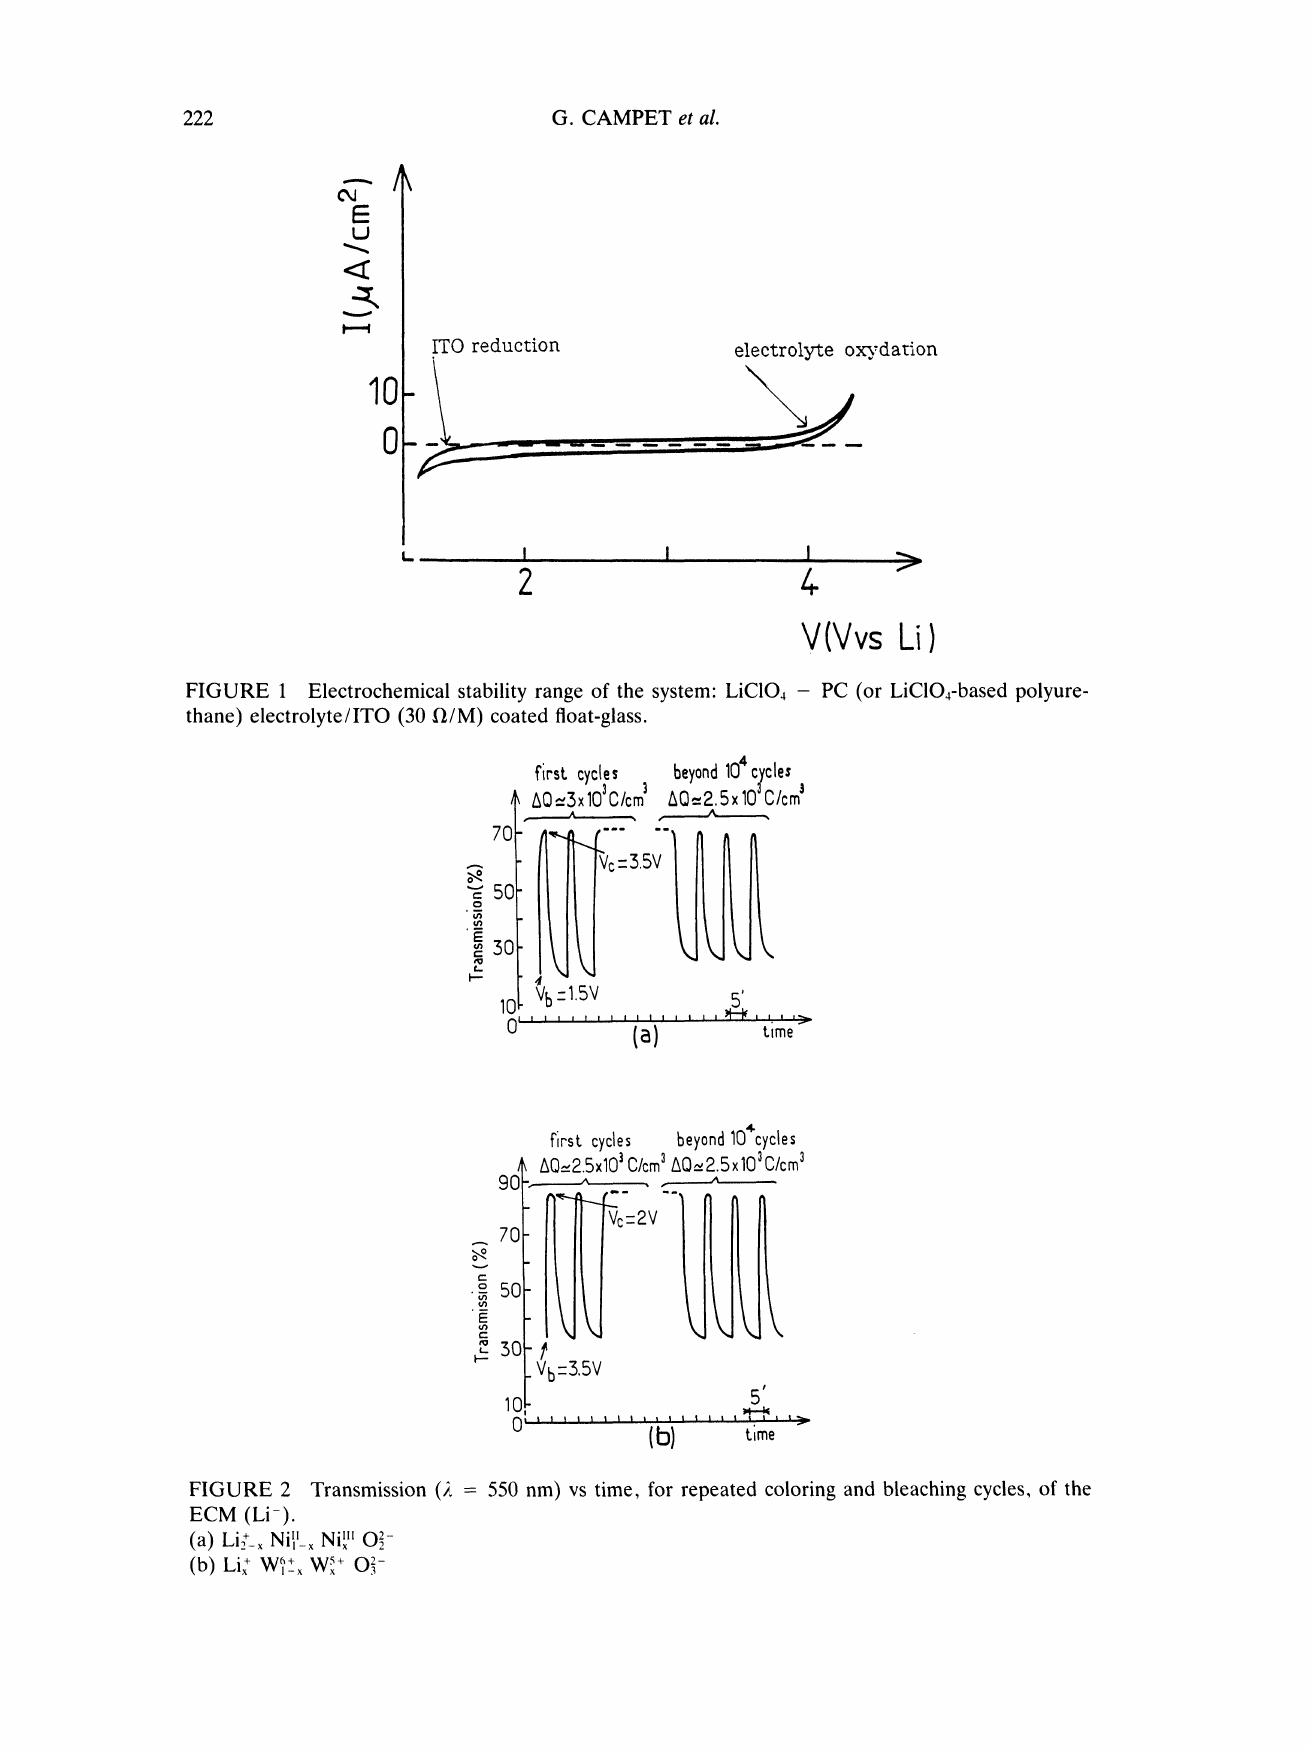
FIGURE 2 Transmission (). 550 nm) vs time, for repeated coloring and bleaching cycles, of the ECM (Li-). (a) Li_x Nil’-x Ni O- (b) Li$ W_ +, W